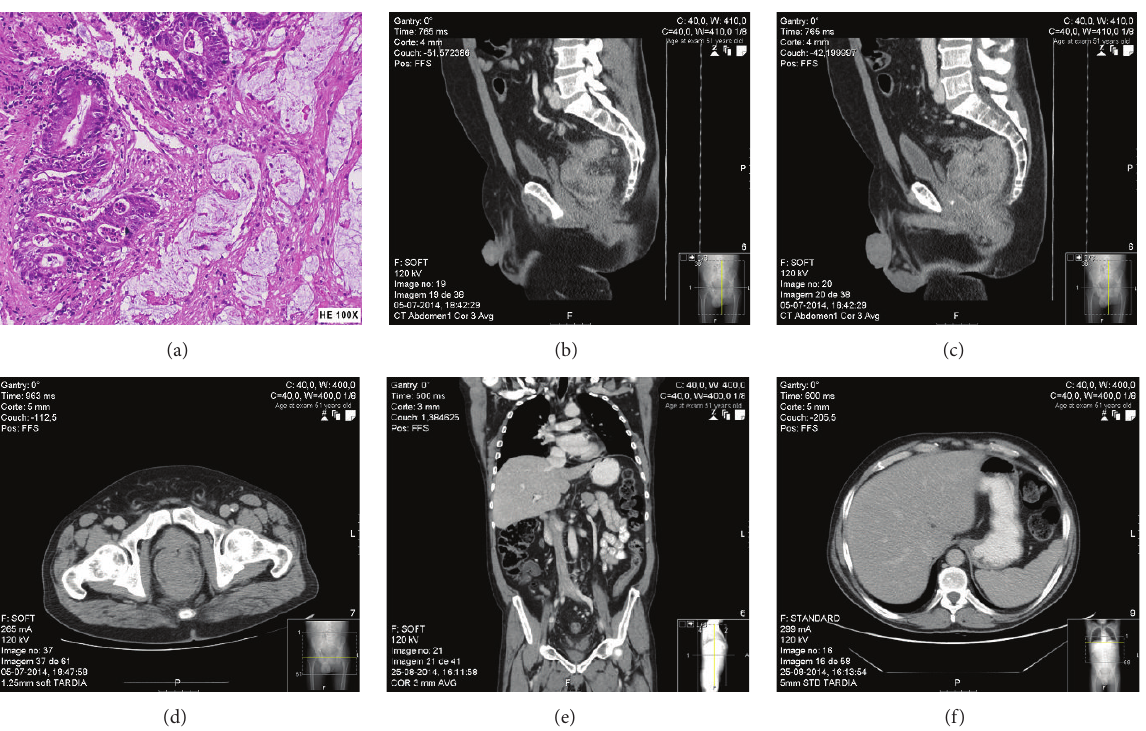
Figure 1: Diagnosis and staging. (a) Rectal biopsy mucinous adenocarcinoma; (b), (c), (d), (e), and (f) CT scan large tumor with 9 cm of longitudinal length and 7 cm of transverse diameter, plan between tumor and prostate not evident, multiple enlarged pelvic lymph nodes, and no evidence of inguinal nodal involvement or distant